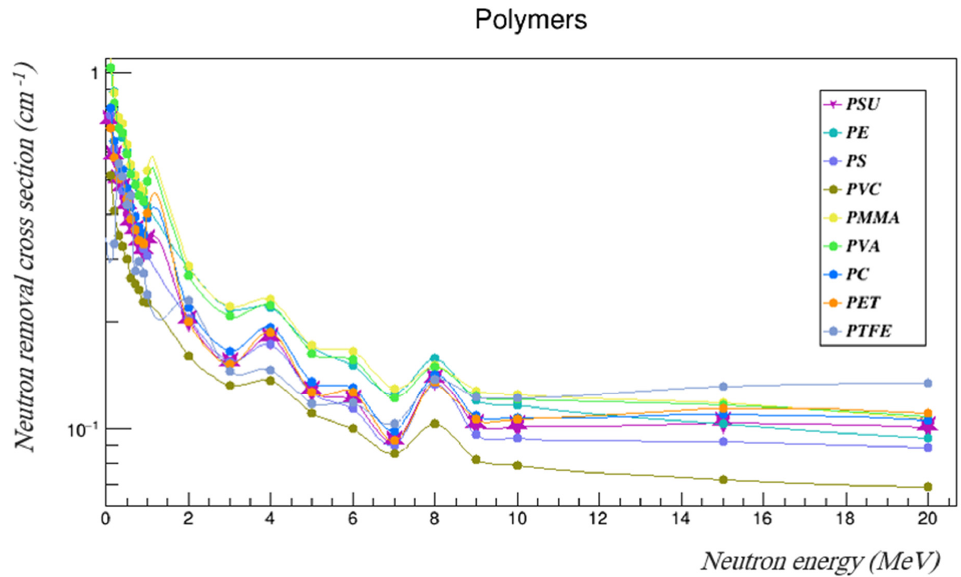
Figure 10. The neutron removal cross-sections of the polymers compared to PSU at the studied energy range. Table 11. The fast neutron removal cross-sections of all investigated polymers.